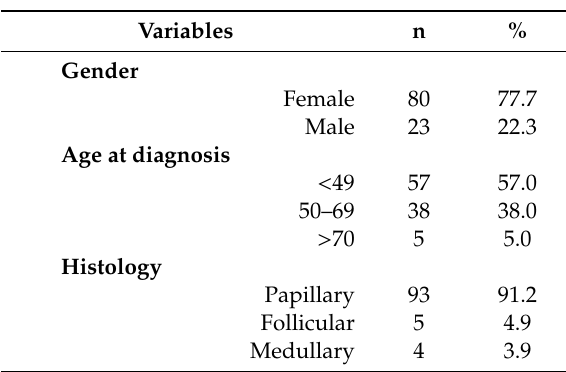
Table 1. Characteristics of cases.